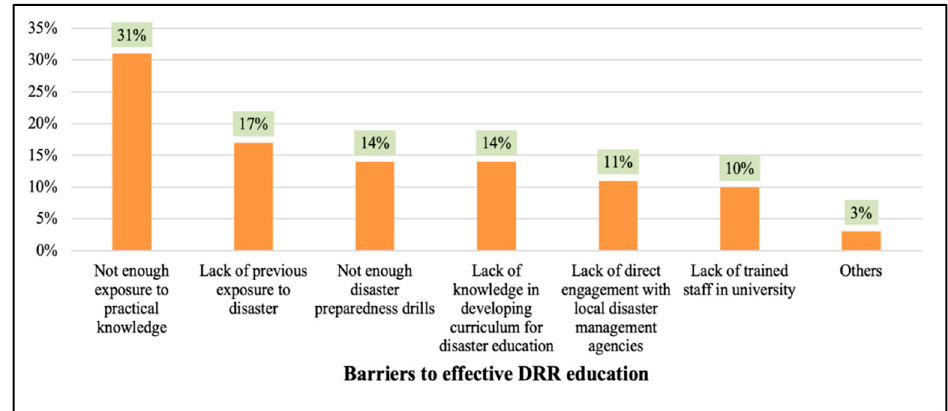
Figure 3. Analysis of students’ perception of barriers to effective DRR education.